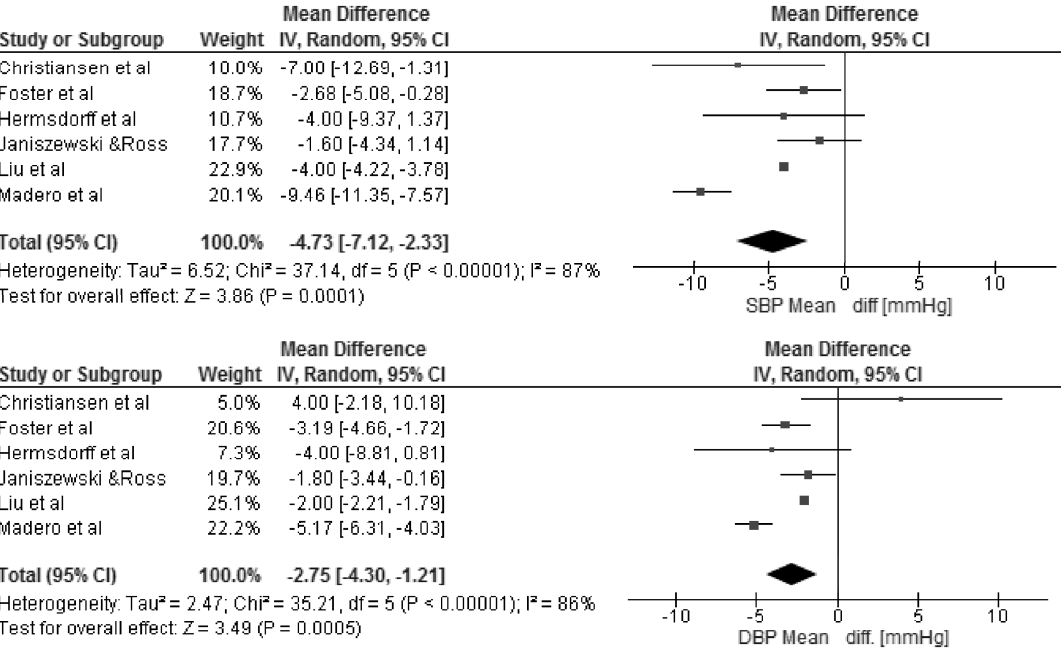
Figure 4. Forest plot of the random ‐ effects meta ‐ analysis of changes in Systolic and Diastolic Blood Pressure according to reduction in energy intake shown as polled standard differences in the means with 95% Cis and in randomized and non ‐ randomized trials. * For each study, the square represents the point estimate of the intervention effect. Horizontal lines join the lower and upper limits of the 95% CI of this effect. The area of shaded squares reflects the relative weight of the study in the meta ‐ analysis. Diamonds represent the subgroup mean difference and pooled mean differences. CI indicates confidence interval.